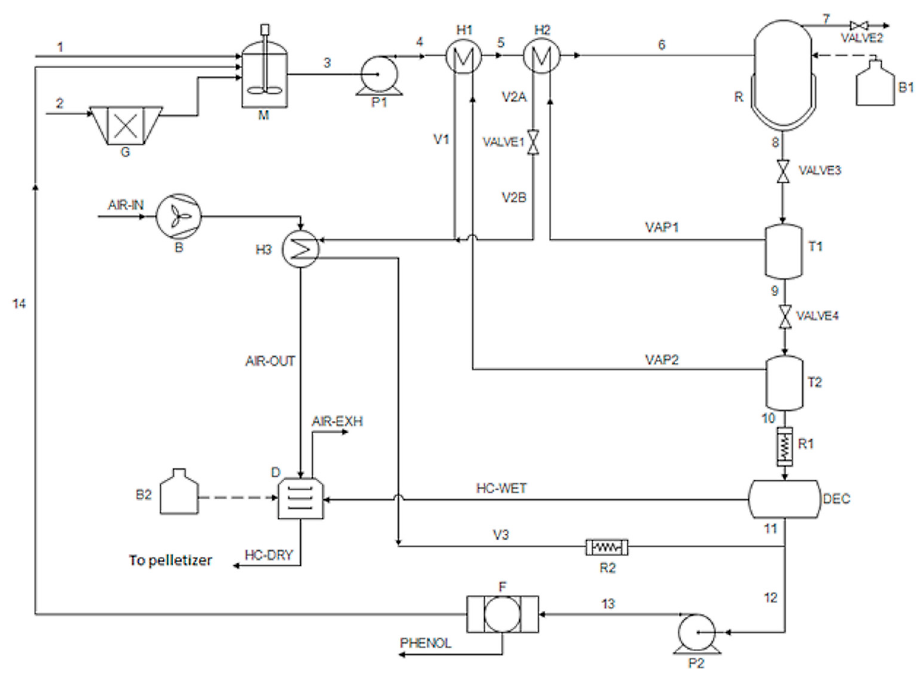
Figure 2. Schematic flow sheet of the HTC plant.